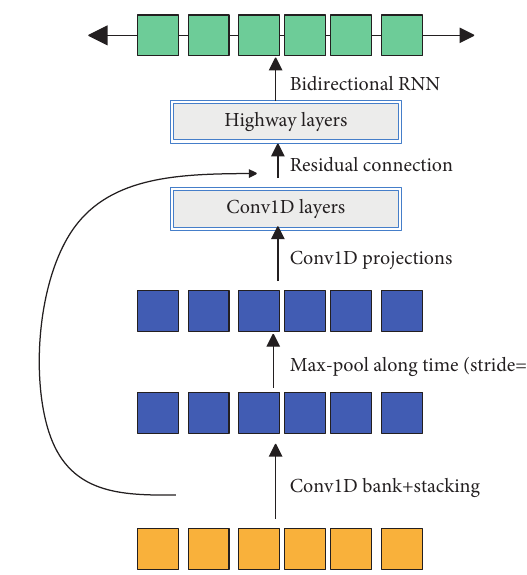
Figure 3: The overall structure of the Tacotron model.